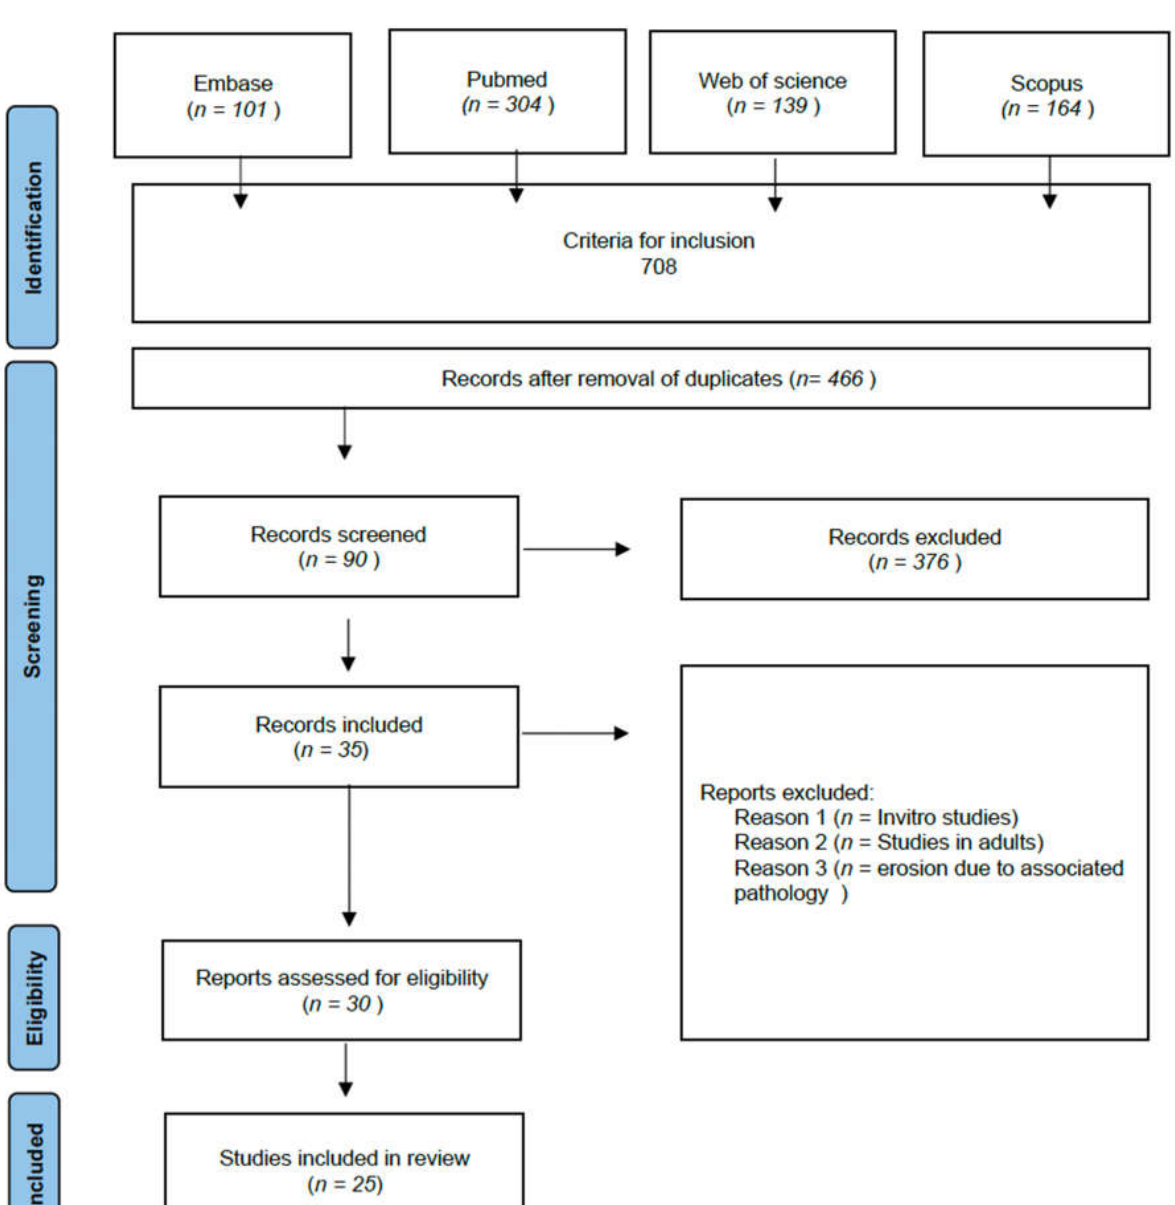
Figure 1. PRISMA flowchart of study selection process.